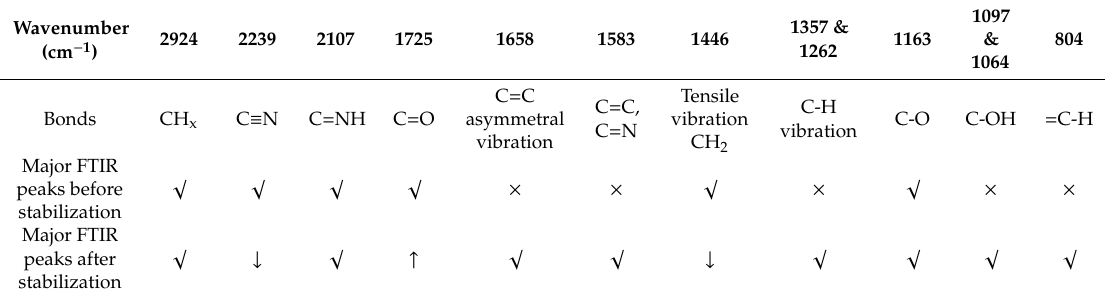
Table 1. Major peaks to be characterized in FTIR spectra.